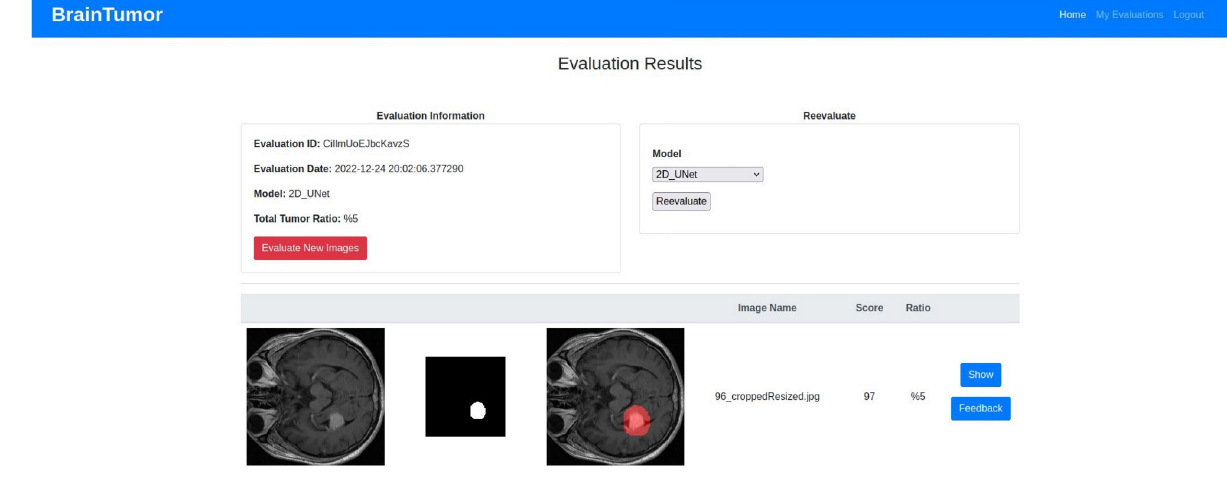
Fig 17. Evaluation results